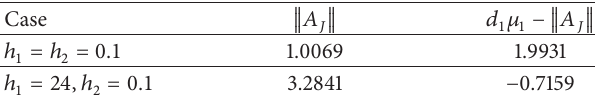
Table 1: Values of the simulation